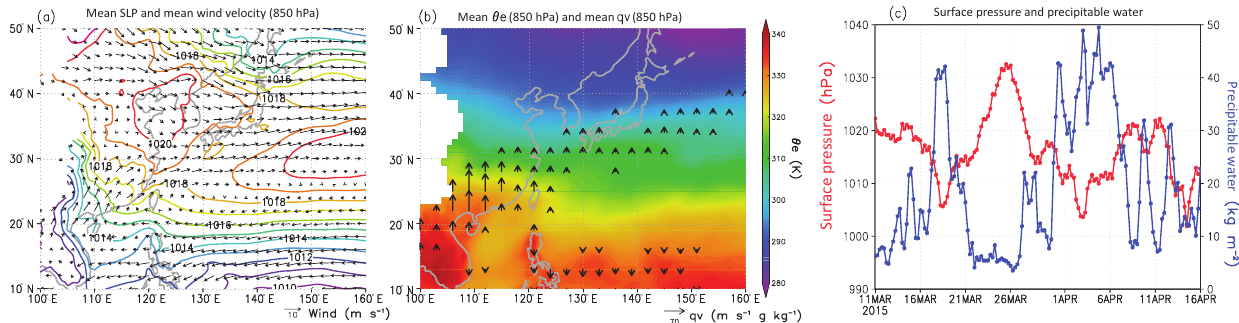
Figure 3. Meteorological fields in east Asia during the observation period (11 March–14 April 2015) based on NCEP FNL data. (a) Mean SLP (hPa, contours) and mean horizontal wind velocity at the 850hPa level (ms − 1 ) . Regions without data correspond to those of high- altitude mountains. (b) Mean θe (K) and total meridional moisture transport (qv values) at the 850hPa level (ms − 1 gkg − 1 ) . Only qv vectors with magnitudes greater than 10ms − 1 gkg − 1 were plotted. (c) Temporal variations in the surface pressure (hPa; red line and markers, left axis) and precipitable water (kgm − 2 ; blue line and markers, right axis) at the Fukue observation site (32.75 ◦ N, 128.68 ◦